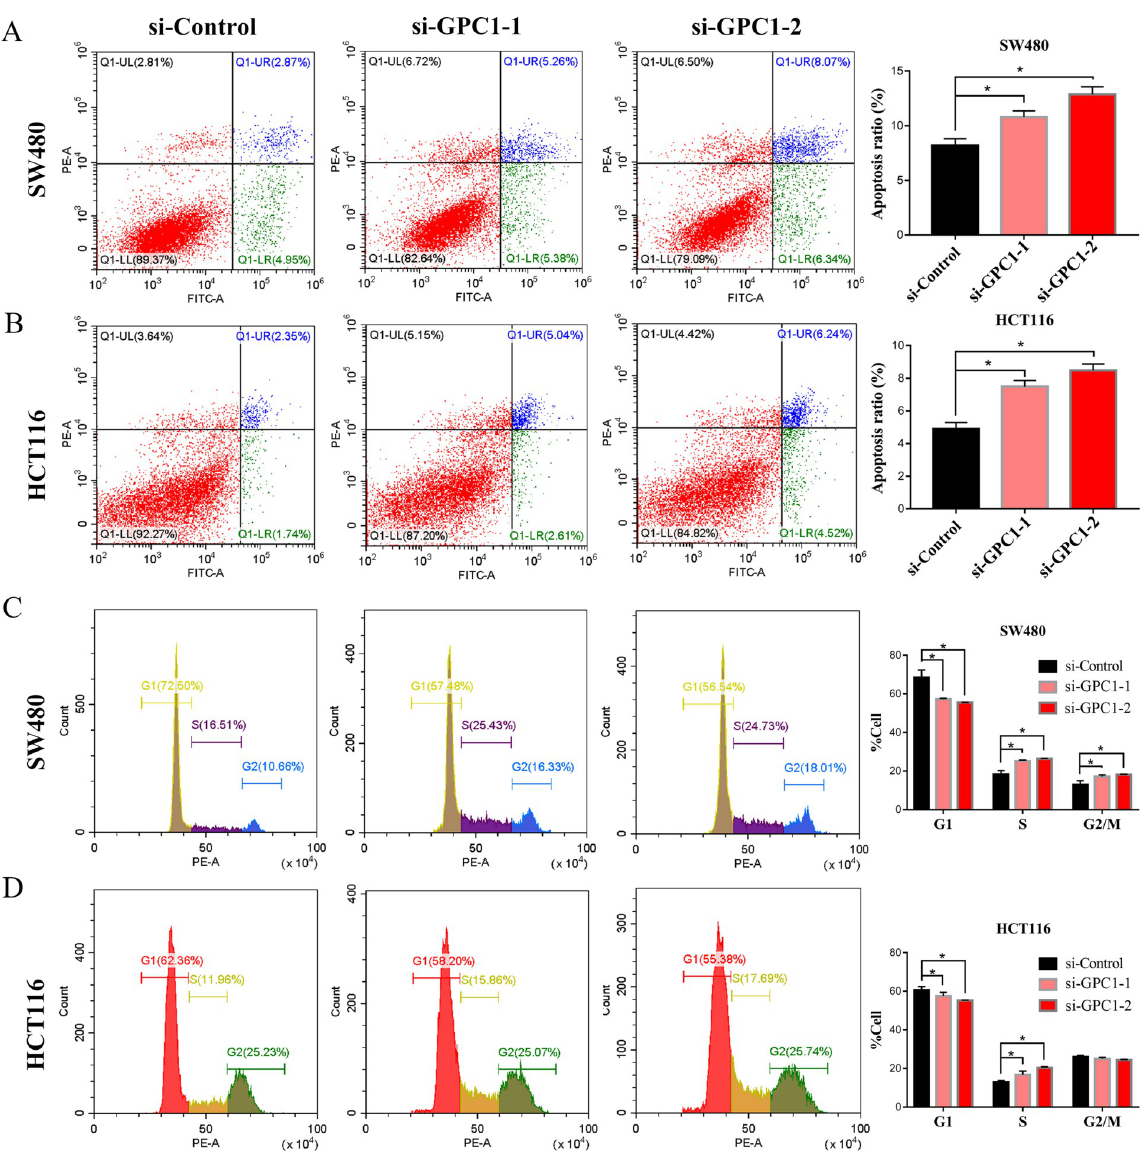
Fig 4. Knockdown of GPC1 induces apoptosis and S phase cell cycle arrest in CRC cells. (A, B). GPC1 silencing promoted SW480 and HCT116 cell apoptosis. (C, D). Knockdown of GPC1 induced S cell cycle arrest in SW480 and HCT116 cells. � p < 0.05.